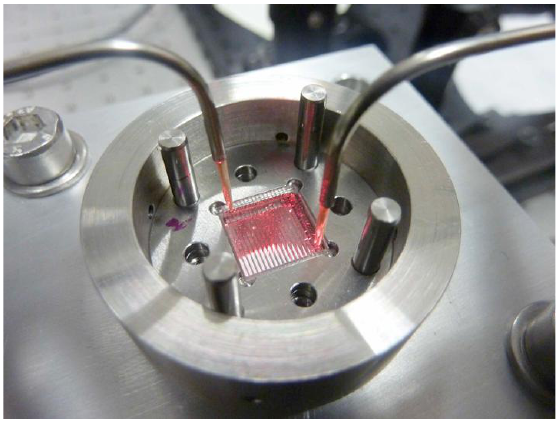
Figure 4. One of the microlens array elements in the slicer being aligned using a set of micromanipulators. The array is illuminated from below using a red laser and the spot pattern matched to a printed target produced from ray tracing of the ideal optical